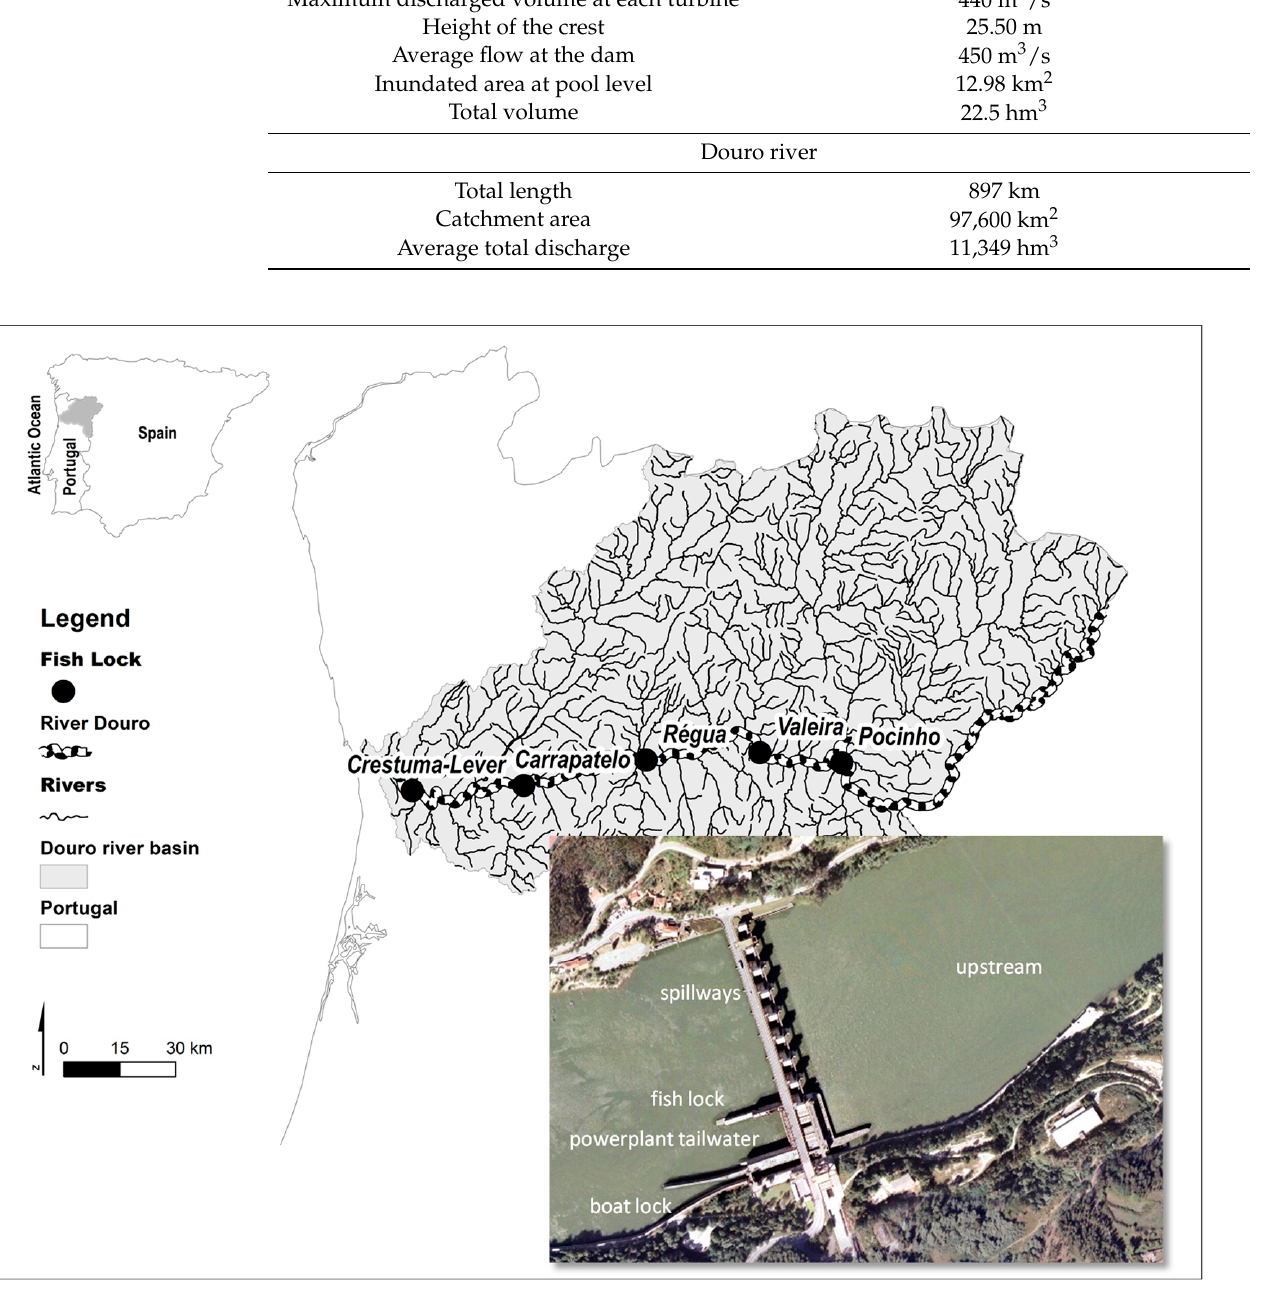
Figure 1. The last 325 km of the Douro River showing the existing dams in Portugal. Insert: Crestuma-Lever dam, depicting the spillways, powerplant tailwater and the fish and boat locks (Image Source: Municípia S.A.).